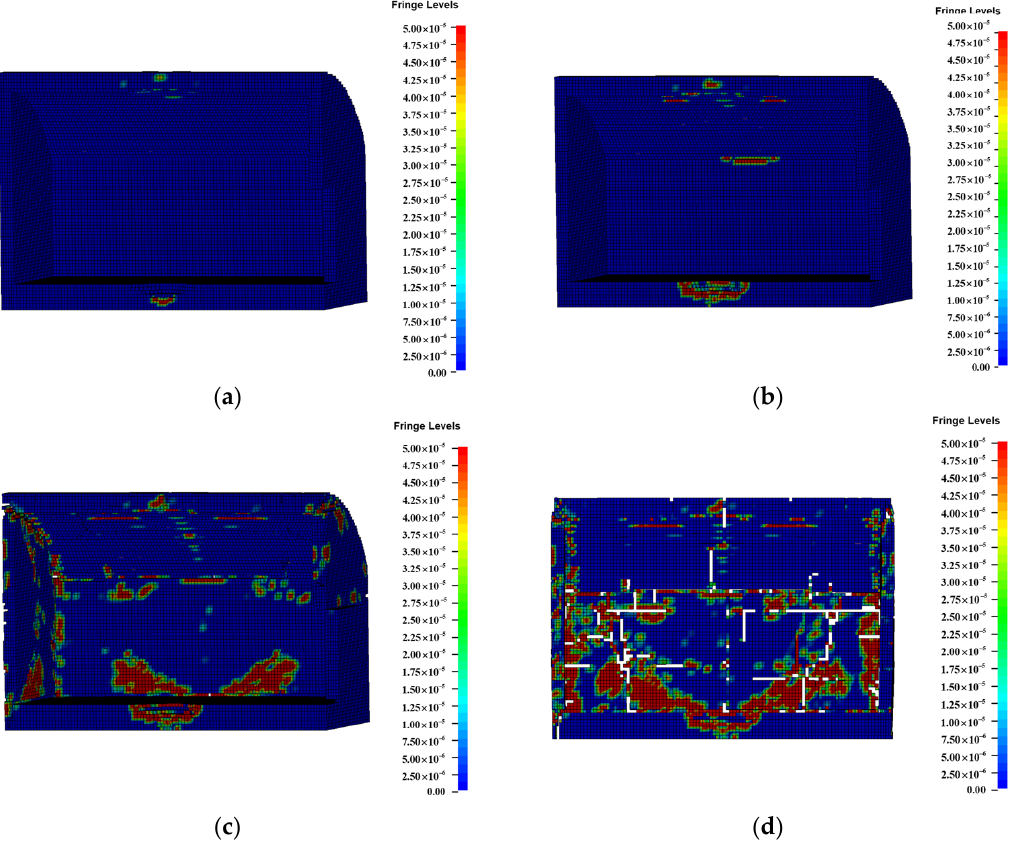
Figure 20. Structural crack development. ( a ) 0.13 ms; ( b ) 0.16 ms; ( c ) 0.48 ms; ( d ) 1.2 ms.